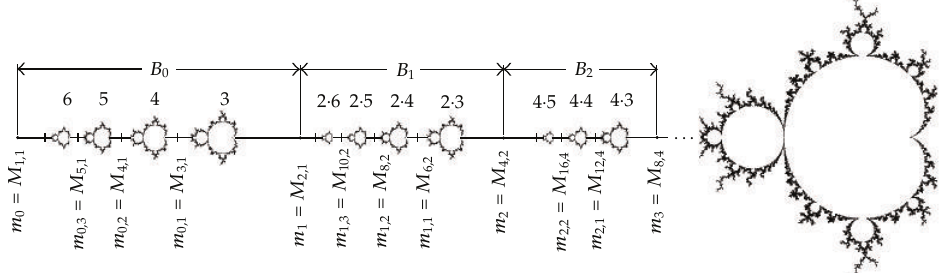
Figure 1: Mandelbrot set and a sketch of the antenna showing the first three chaotic bands B 0 , B 1 , and B 2 separated by the merging points m i . In each chaotic band, the more important HCs and Misiurewicz points are